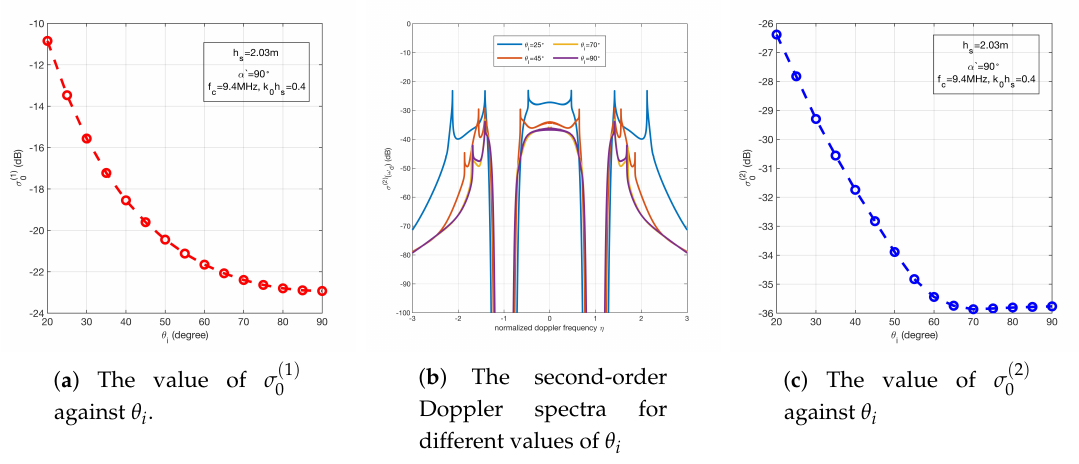
( 1 ) Figure 7. ( a ) The values of σ for 20 ◦ ≤ θ i ≤ 90 ◦ . ( b ) The second-order Doppler spectra σ ( 2 ) ( ω d , θ i ) 0 for several incident angles θ i , i.e., θ i = 25 ◦ ,45 ◦ ,70 ◦ and 90 ◦ . ( c ) The values of σ h s = 2.03 m, α (cid:48) = 90 ◦ and f c = 9.4 MHz are assumed for (a), (b) and